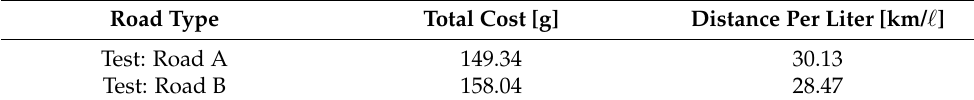
Table 4. The total cost of proposed method at convergence.